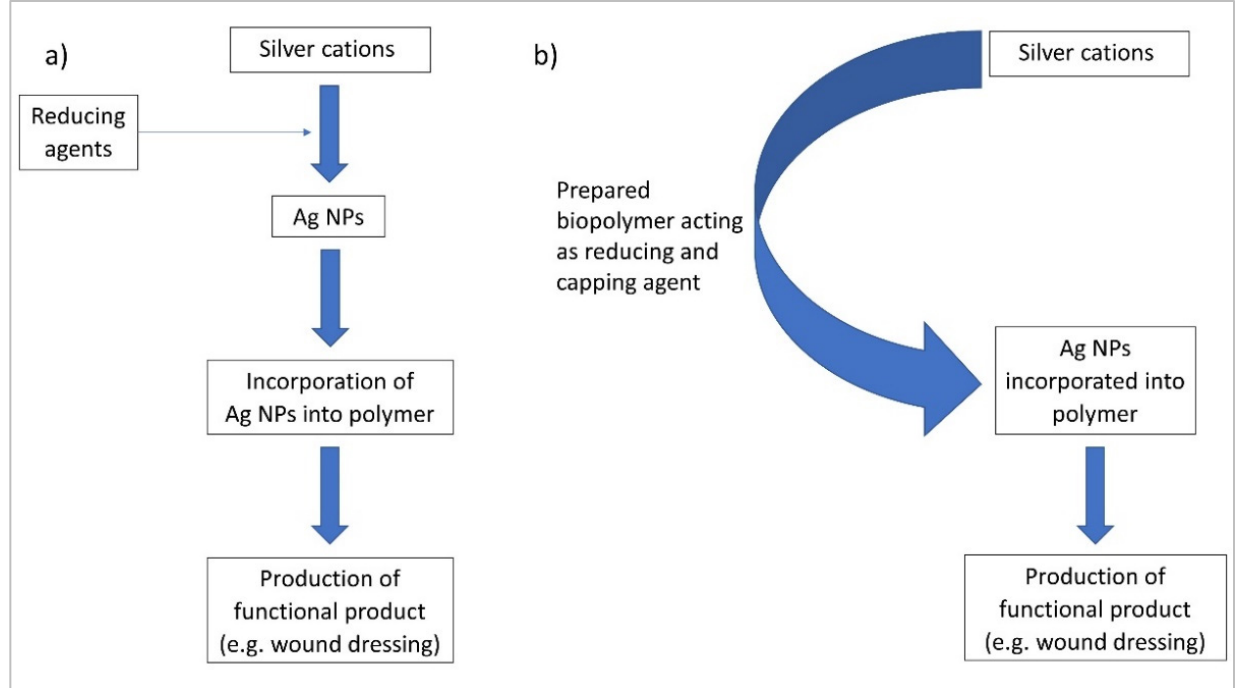
Figure 2. Examples of Ag NPs biopolymer synthesis pathways: ( a ) a typical approach and ( b ) using the biopolymer as reducing agent.